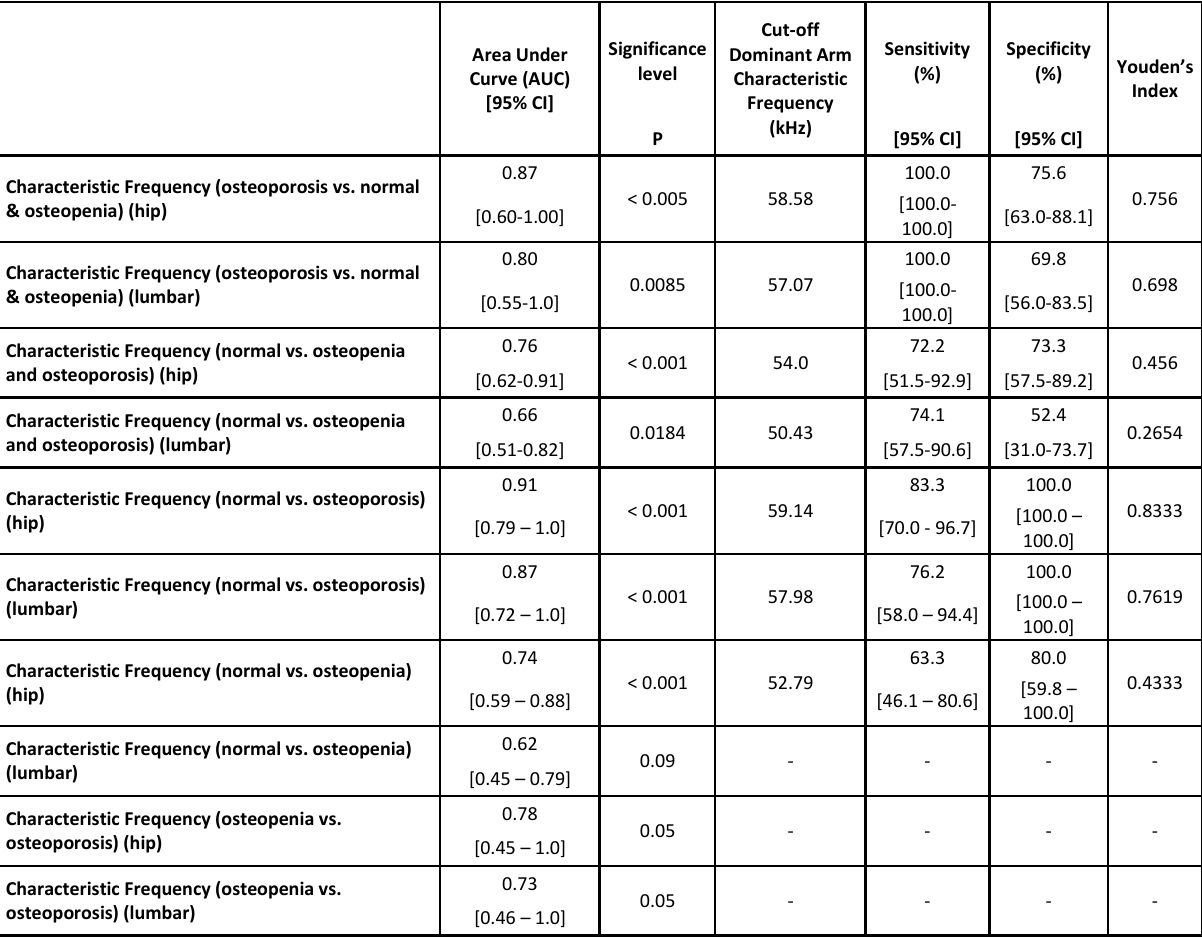
Table 5. ROC curve